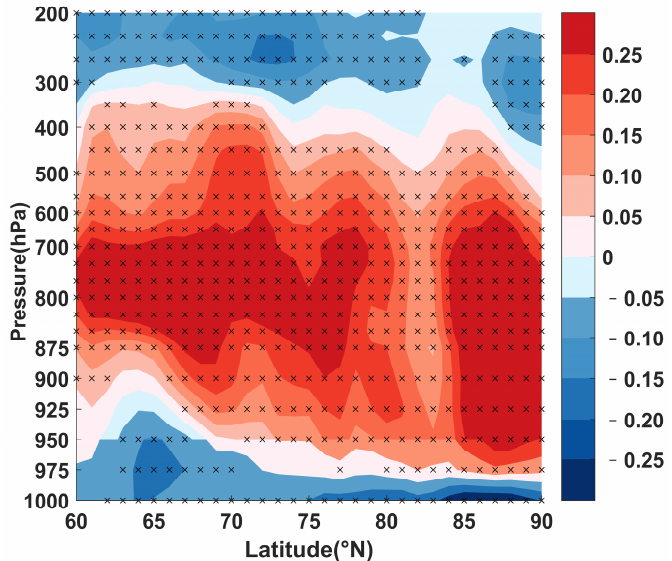
Figure 5. Correlations between zonal averaged daily cyclone frequency and cloud fraction in the autumns of the period 2001–2017 based on the ERA5 reanalysis data. The black cross denotes the 95% con fi dence level.